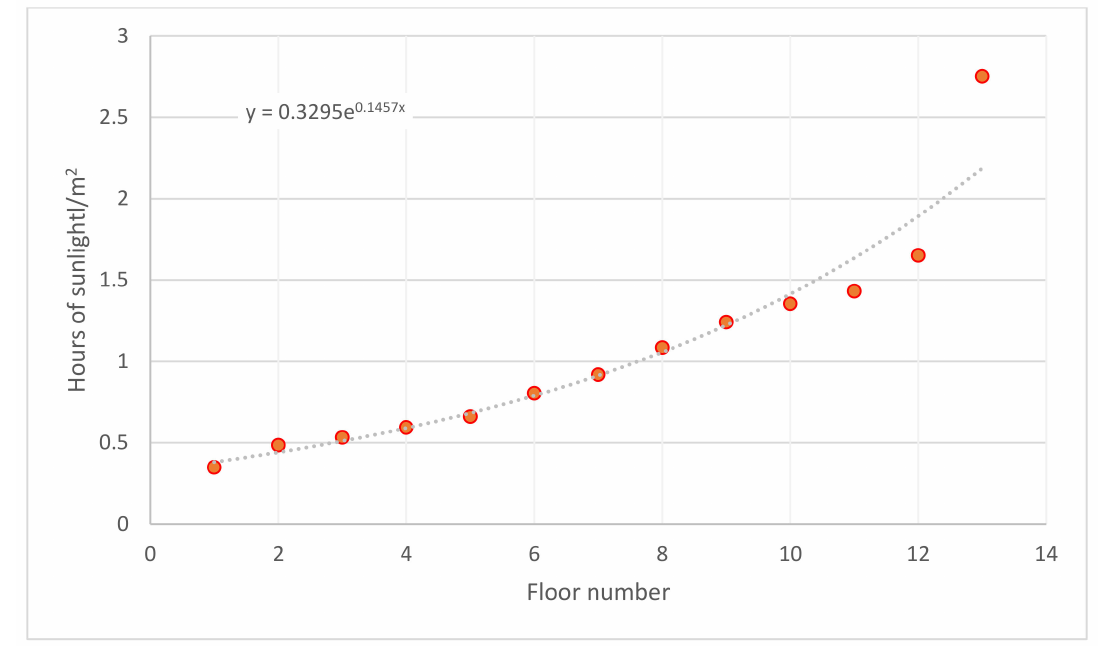
Figure 9. Relation between the floor number of the sample building and the sunlight hours per accumulated